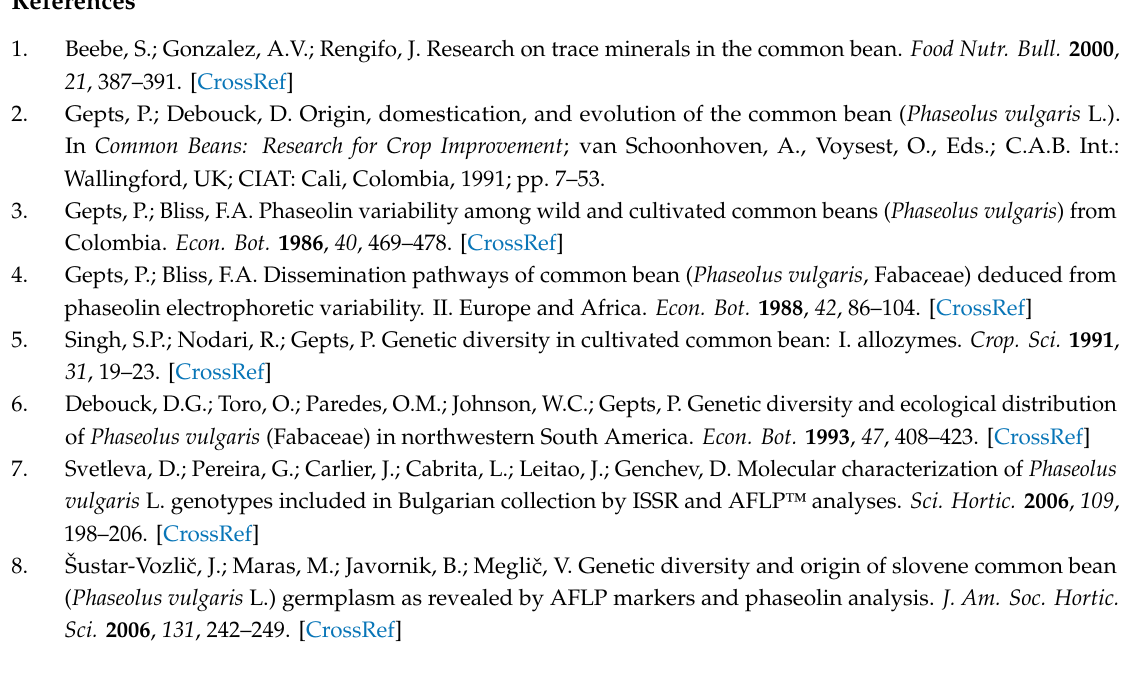
di ff erent areas of Sicily, based on six seed descriptors. In red group number of morphotype also reported in Figure 3, Figure S3: Frequency distribution of six classes of 100-seed weight (g) within the 57 Phaseolus vulgaris L. landraces, Figure S4: Relationships between determinate and indeterminate Sicilian accessions and Andean (Jalo EEP558, Midas) and Mesoamerica (BAT93) references as represented by the first two principal coordinates of a Principal Coordinates Analysis (PCoA) using allelic profiles from 8 SSR molecular markers, Table S1: Quanti-qualitative descriptors of seed, flower, leaf and pod recorded on fifty-seven Phaseolus vulgaris L. landraces conserved at SPGR / PA, Table S2: Percentage of seed with di ff erent striped seed coat color recorded on four landraces across three years, Table S3: Descriptive statistic of quantitative variables detected on 57 Sicilian landraces. SH = seed height; SW = seed width; SL = seed length; PL = pod length; S × P = seed / pod; 100W = 100-seed weight; Y = dry bean yield; SD = Standard Deviation, CV = Coe ffi cient of Variation expressed as a percentage, Table S4: Analysis of variance (ANOVA) of quantitative parameters, SH = seed height; SW = seed width; SL = seed length; PL = pod length; S × P = seed / pod; 100W = 100-seed weight; Y = dry bean yield, Table S5: Means comparison and post hoc test (Tukey’s) for quantitative parameters. SH = seed height; SW = seed width; SL = seed length; PL = pod length; SxP = seed / pod; 100W = 100-seed weight; Y = dry bean yield. Only dry bean yield (Y) parameter was compared to Borlotto type as control, Table S6. Accession number, local name, collection site (CS), geographic coordinates sites (GCS) and macro sites of sampled landraces, Table S7: Rare alleles detected on landraces in homozygous or heterozygous state, Table S8: Posterior membership coe ffi cients following a STRUCTURE analysis and K = 4, Table S9: List of BI / CIAT descriptors (2009) and code number used for morphological characterization of Sicilian common bean germplasm collection. Numbers in parentheses, under each descriptor,